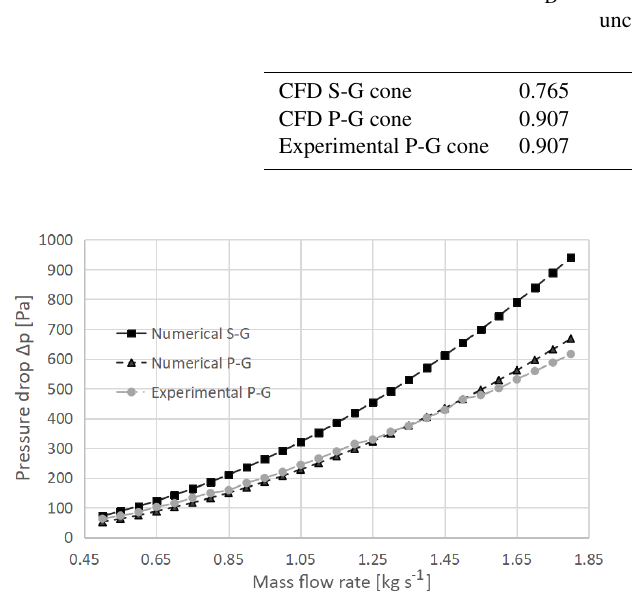
Figure 23. Pressure drop due to the cone for both geometries.